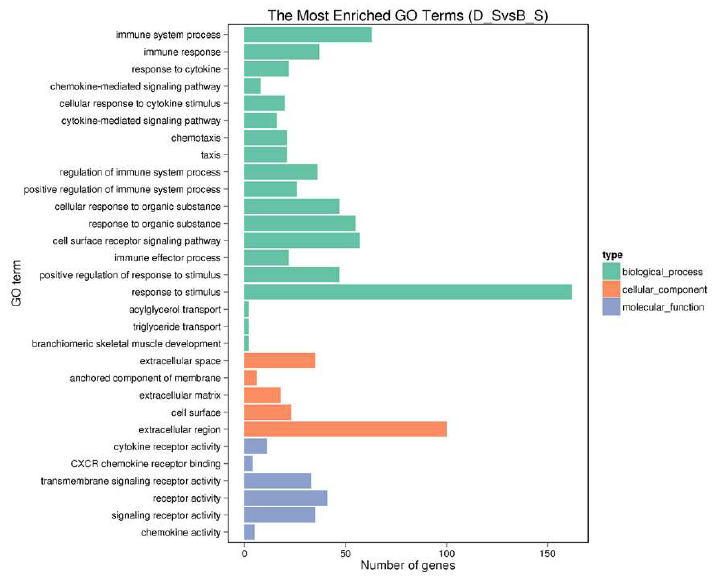
Figure 4. The top 30 enriched gene ontology (GO) terms of SDEGs. The X-axis shows the SDEG number of each GO term; the Y-axis shows the SDEG-enriched GO term.